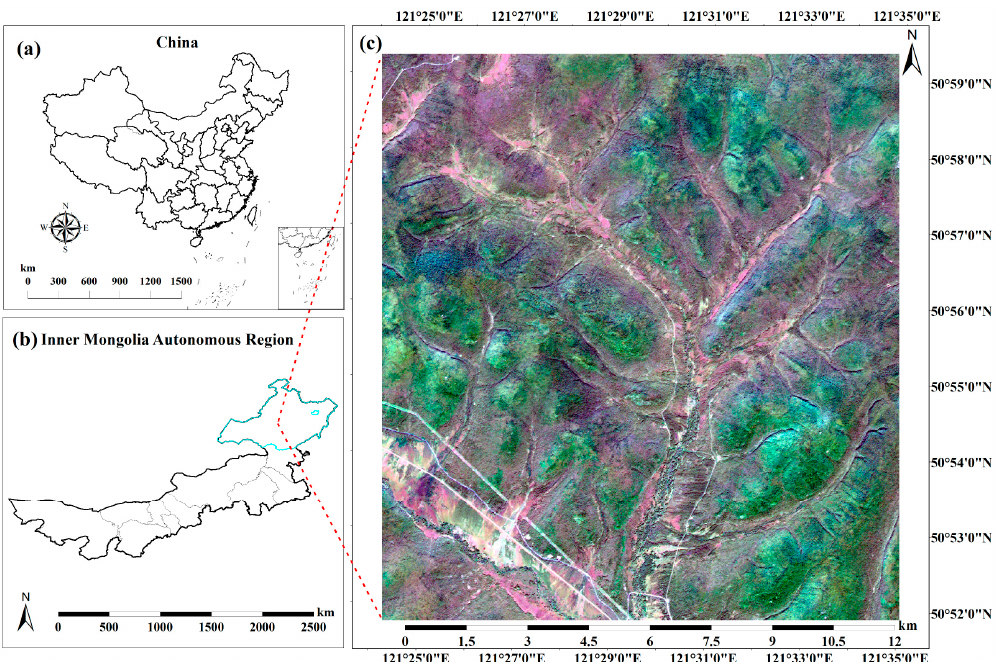
Figure 1. The study area: ( a ) China ( b ) Inner Mongolia Autonomous Region, with blue polygons representing Hulunbeir, ( c ) the Research Area.